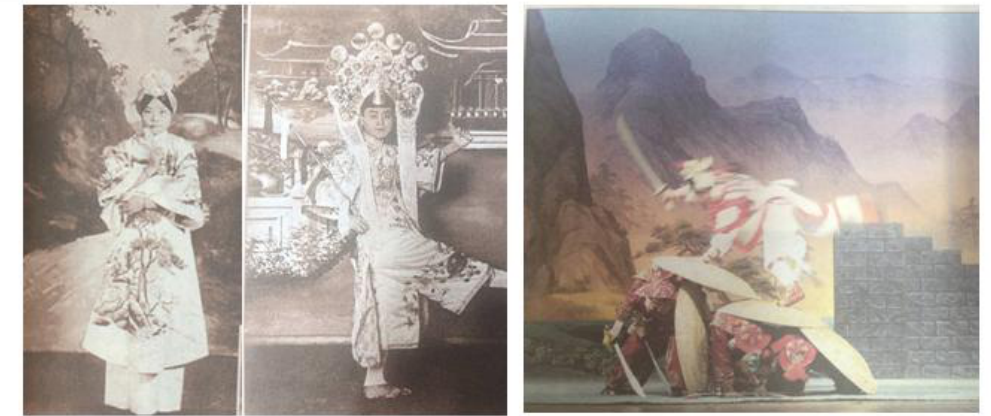
Fig. 6 Dressed young actress of the Cantonese Opera in late 19 th century